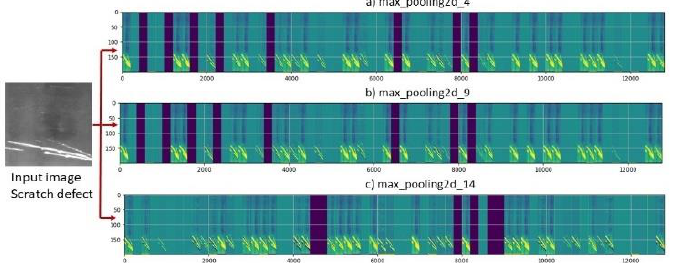
Figure 6. Feature map for three parallel stacks ended with Max_polling layer.